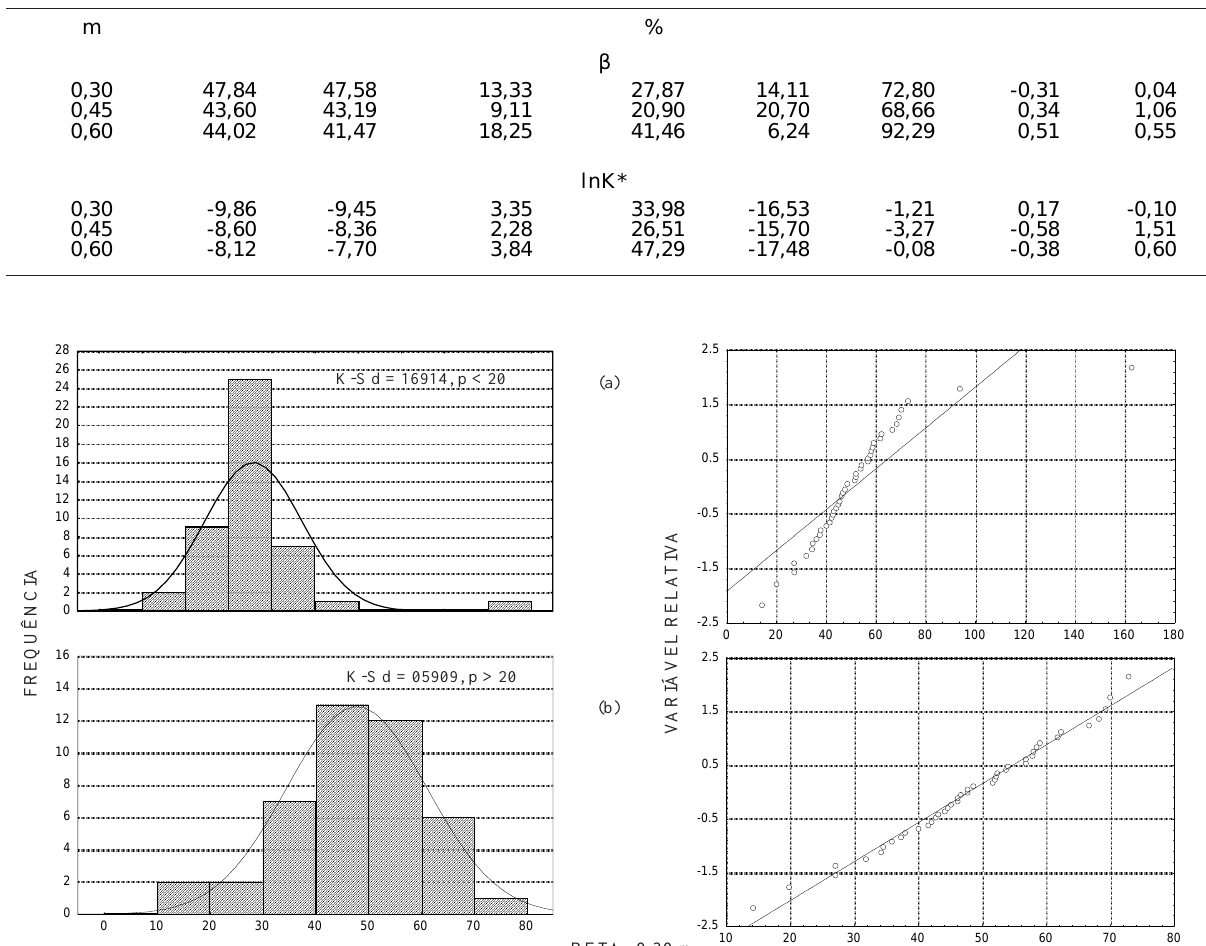
Figura 2. Histogramas de freqüência, teste de Kolmogorov-Smirnov (K-S) e retas de probabilidade de Henry, dos valores originais, para o coeficiente angular ( bbbbb ) da relação lnK = bqbqbqbqbq + lnK*, segundo uma